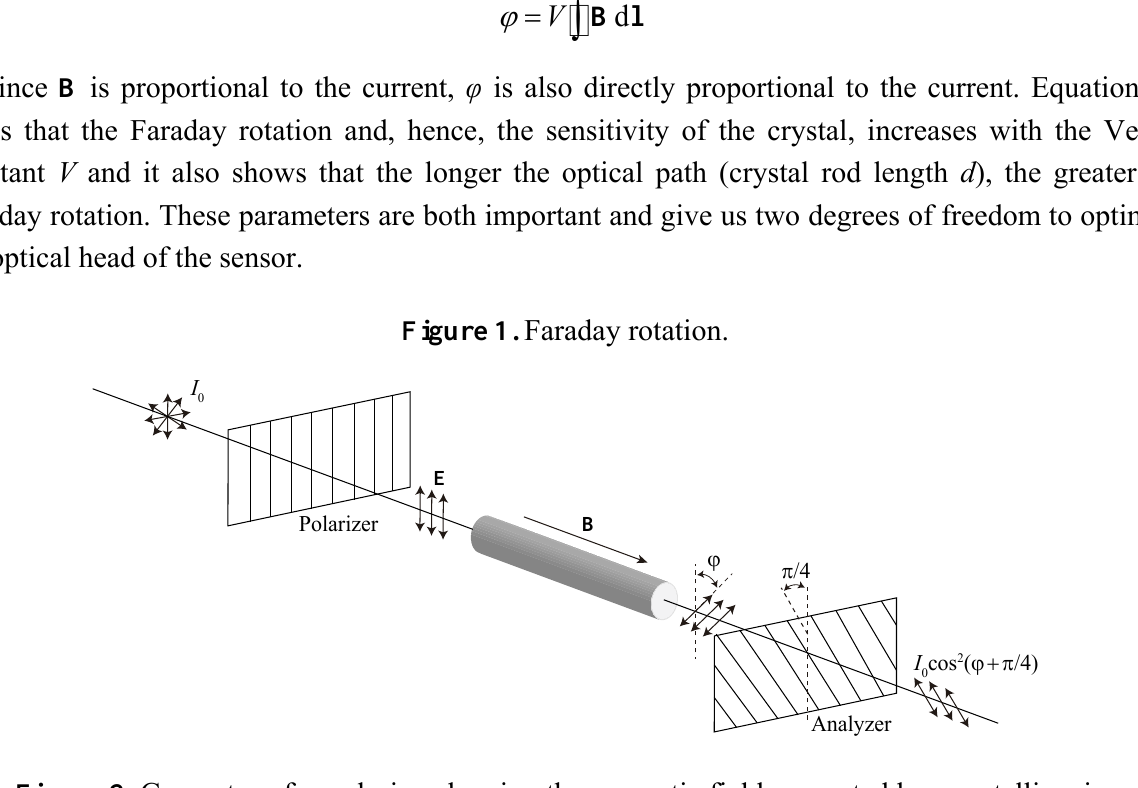
Figure 2. Geometry of our design showing the magnetic field generated by a metallic wire (yellow) around the SF2 glass rod